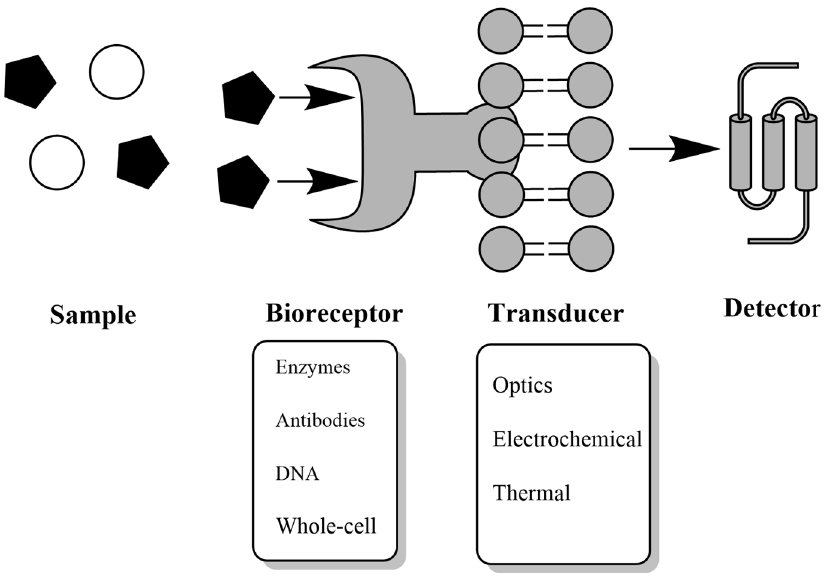
Figure 3. Scheme of a biosensor and rationale for its operation.